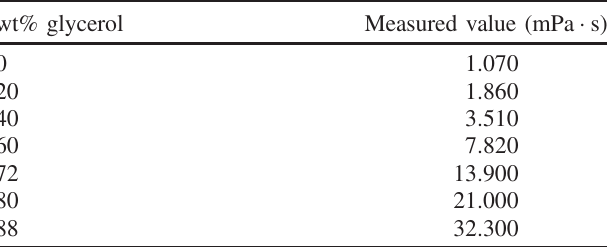
TABLE III. Measured viscosities of water-glycerol mixtures.